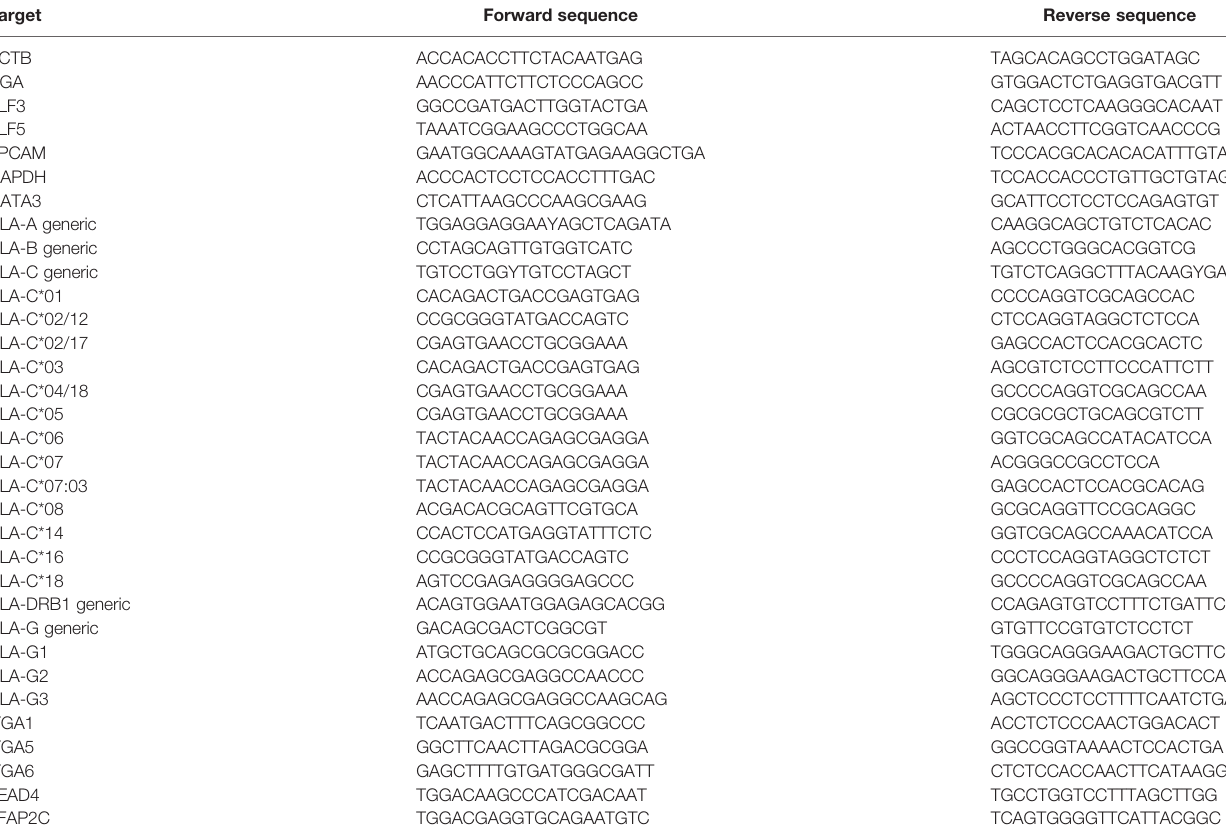
TABLE 1 | Overview of primers used for quantitative PCR assays in the study.